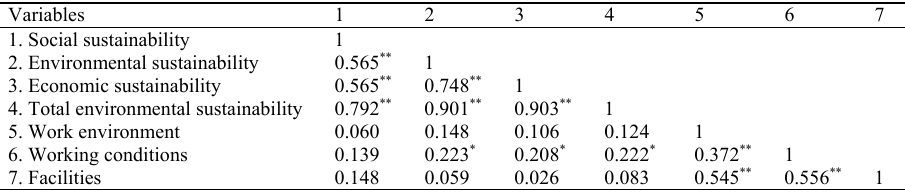
Table 4: Correlation analyses of environmental sustainability and quality of work life Variables